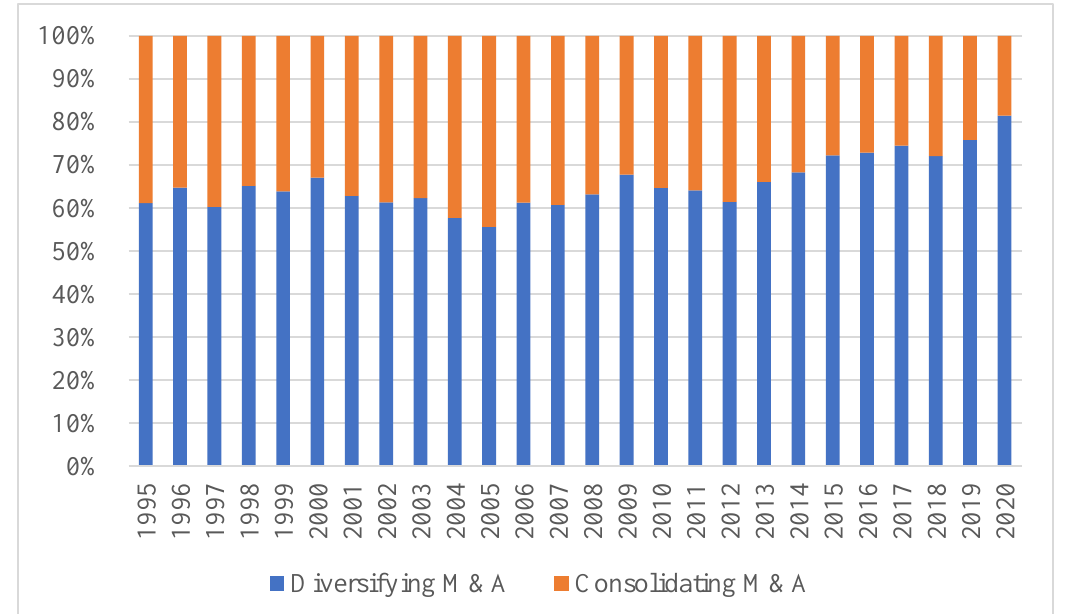
Figure 5. Dynamics of diversifying vs. consolidating M&As in the energy industry.